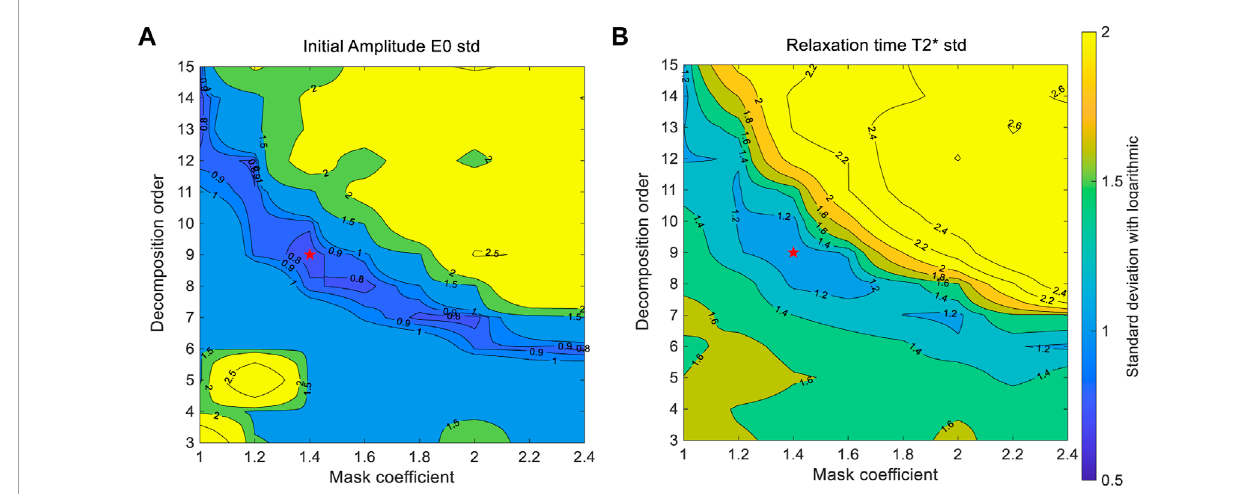
TABLE1 ProcessingresultsofALIFalgorithmunderdifferentnoisetypesandnoiseamplitudesand T *